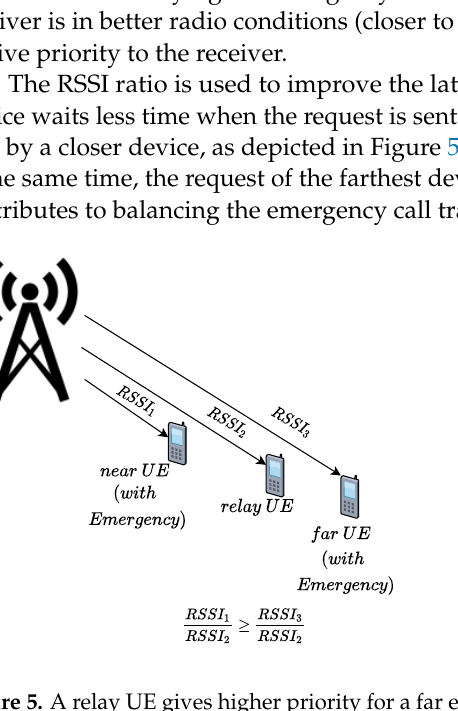
Figure 5. A relay UE gives higher priority for a far emergency UE than a near UE using the RSSI ratio. The RSSI ratio in (4) is lower for a far UE than a near UE. The relay UE waits a lesser time, hence relays faster the transmissions of the far UE emergency call in the direction of a functioning